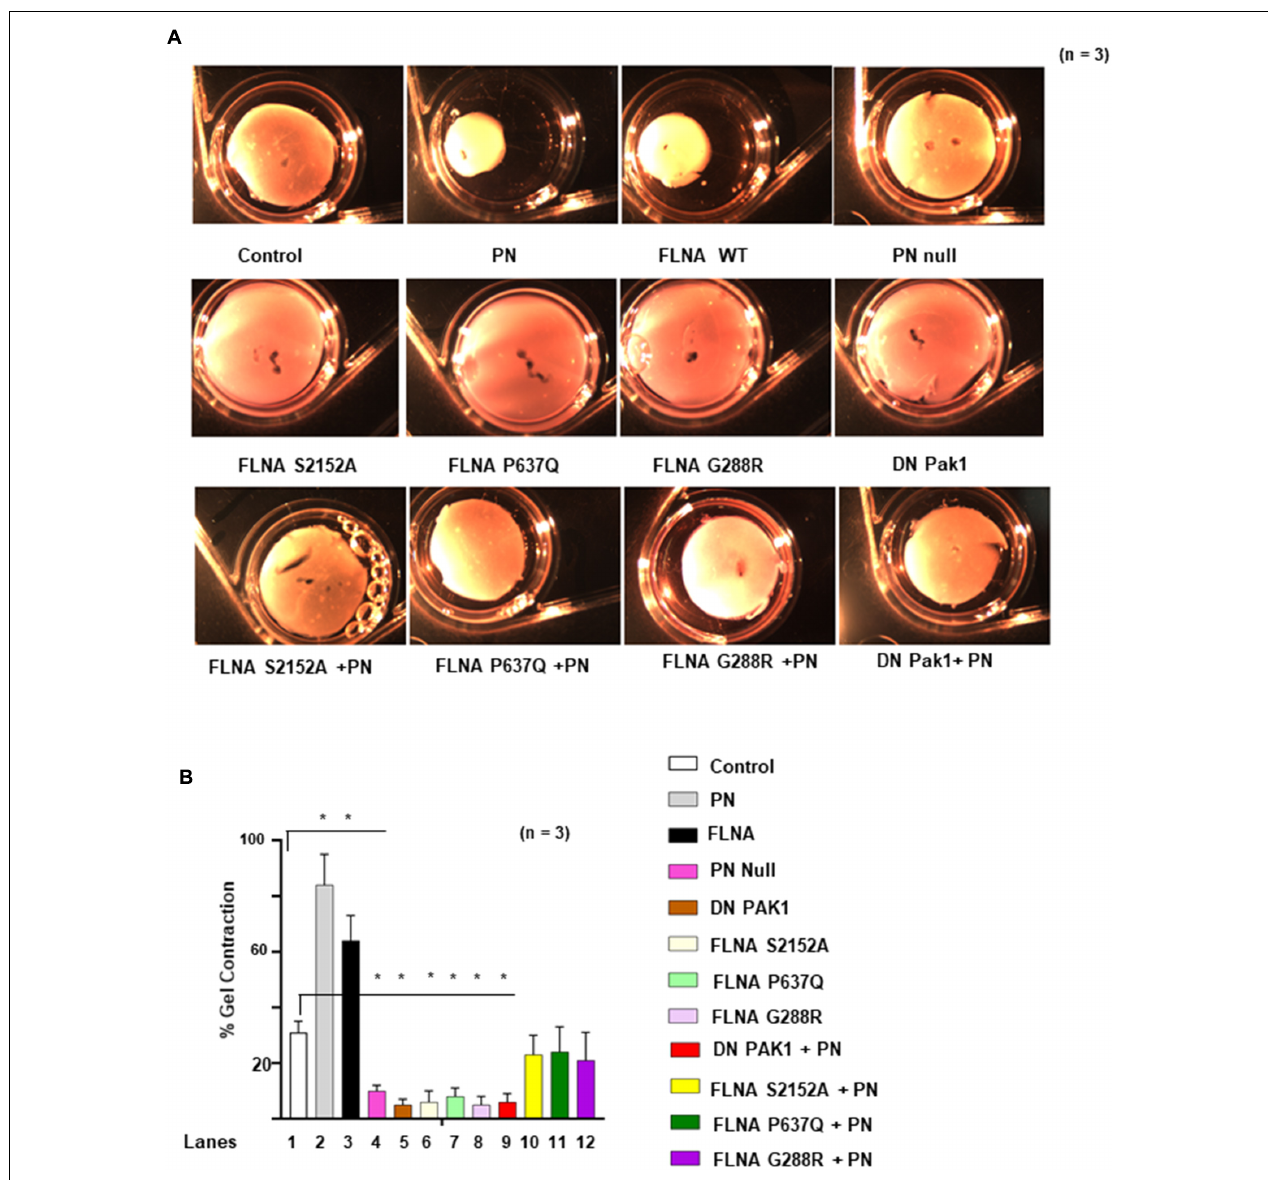
FIGURE 7 | Effects of FLNA mutations [FLNA (P637Q) and FLNA (G288R)] on PN-induced cell differentiation measured by collagen gel compaction. (A) WT VICs were first transfected with the indicated constructs for 72 h before treatment with PN (1 µ g/ml for 1 h). These transfected VICs and untransfected PN null VICs were then embedded in three-dimensional collagen matrices. (B) Matrix contractilities from the experiments in (A) were measured as % area of gel contracted and plotted in panel (B) . Results in panel (A,B) are representative of ≥ 3 separate experiments. Error bars represent SD. * p < 0.01 was considered